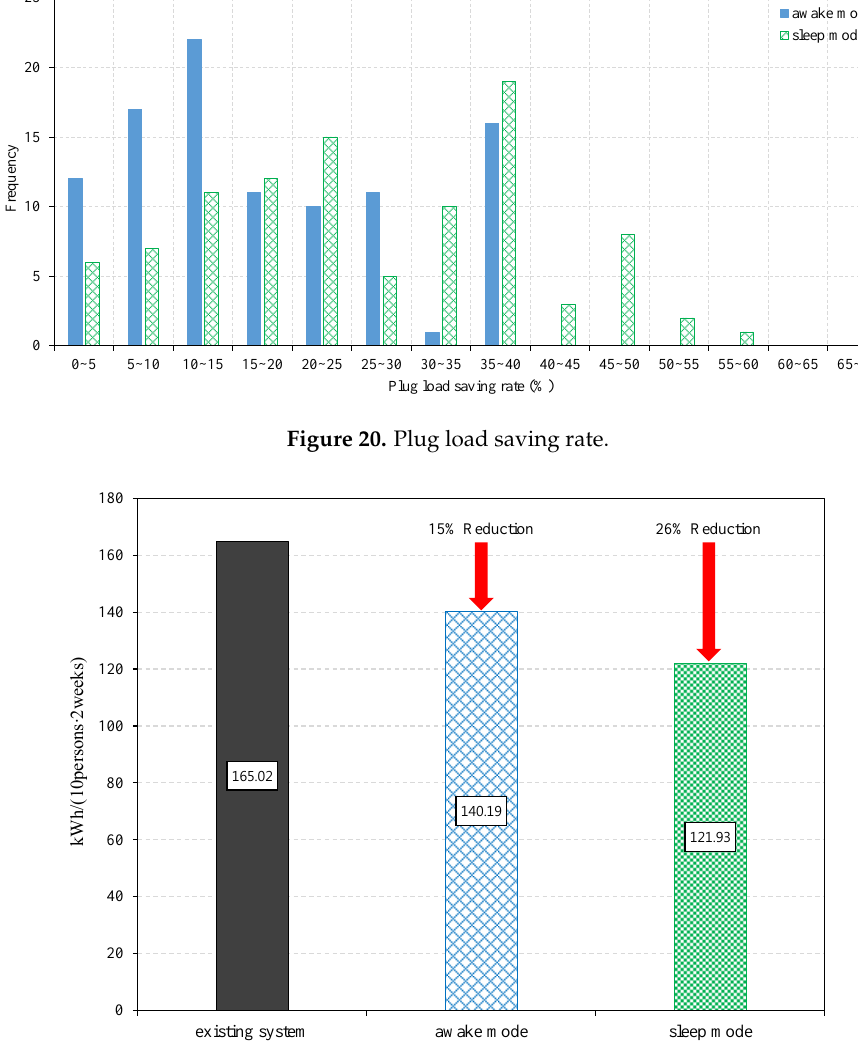
Figure 21. Comparison of plug load.